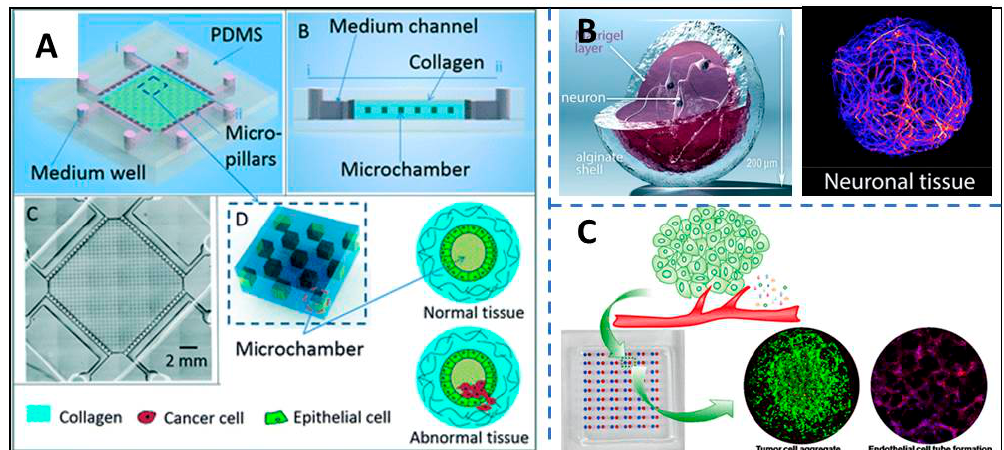
Figure 2. National and polymer hydrogels are utilized to mimic the extracellular matrix (ECM) in microfluidic systems. ( A ) A biomicrofluidic system, using collagen as the ECM, revealed the interactions of tumor and stroma, reproduced with permission from [61]. ( B ) A 3D-printed microfluidic device used alginate hydrogel to produce functionalized hydrogel microcapsules embedding human neuronal stem cells, reproduced with permission from [57]. ( C ) A high-throughput tumor angiogenesis assay was built on the ECM of Matrigel, reproduced with permission from [62].